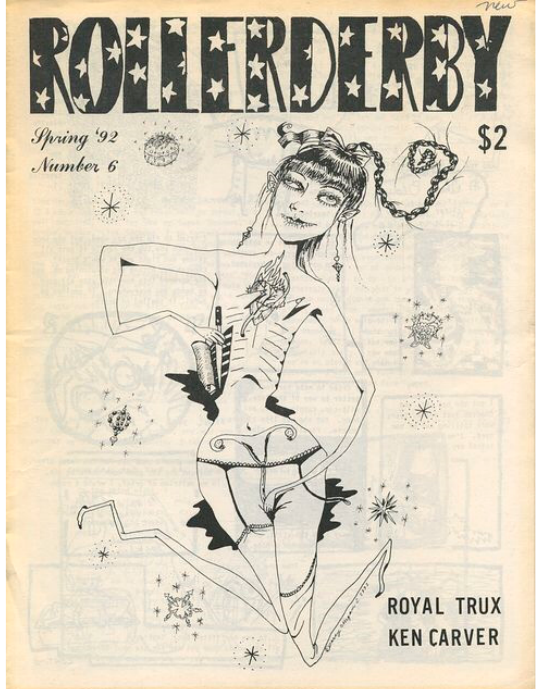
Figure 19. Lisa Carver drawn by Dame Darcy , on the cover of Rollerderby , n° 6, spring 1992.